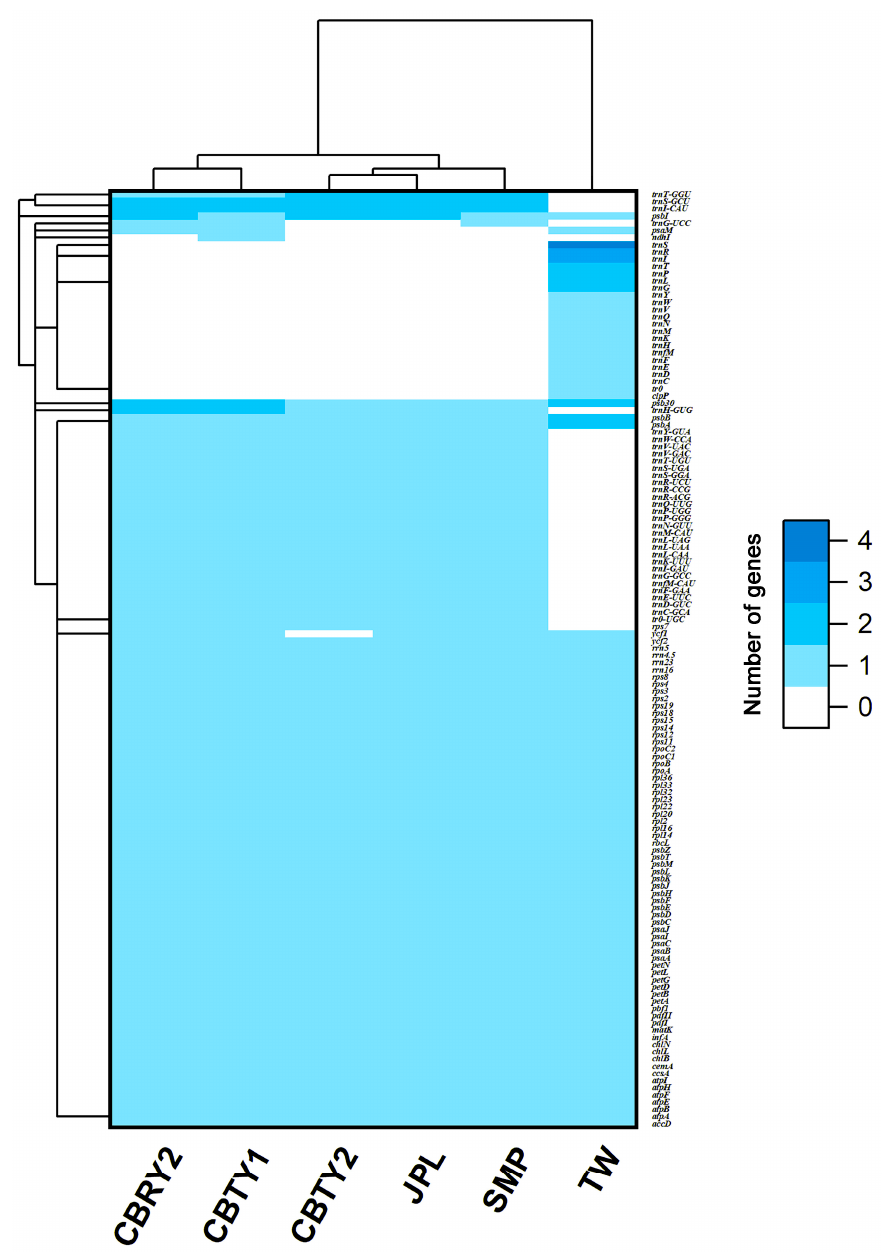
Figure 3. Comparison of chloroplast gene composition between Cathaya argyrophylla populations from different locations in China. CBTY1, CBTY2 and CBRY2 were collected from Chengbu County of Hunan Province. JPL and SMP were collected from Chengzhou City of Hunan Province. TW was collected from Taipei City of Taiwan Province in a previously published study. 3.2. Comparison of C. argyrophylla Chloroplast Genome Sequence Variations The genomic sequence variations were compared between the different locations (Figure 4), given the location-based differences in the chloroplast genomes. CBTY2 was used as a reference sequence since its features were similar to JPY and SMP. The results were quite consistent with the gene composition comparison in that the CBTY2, JPL and